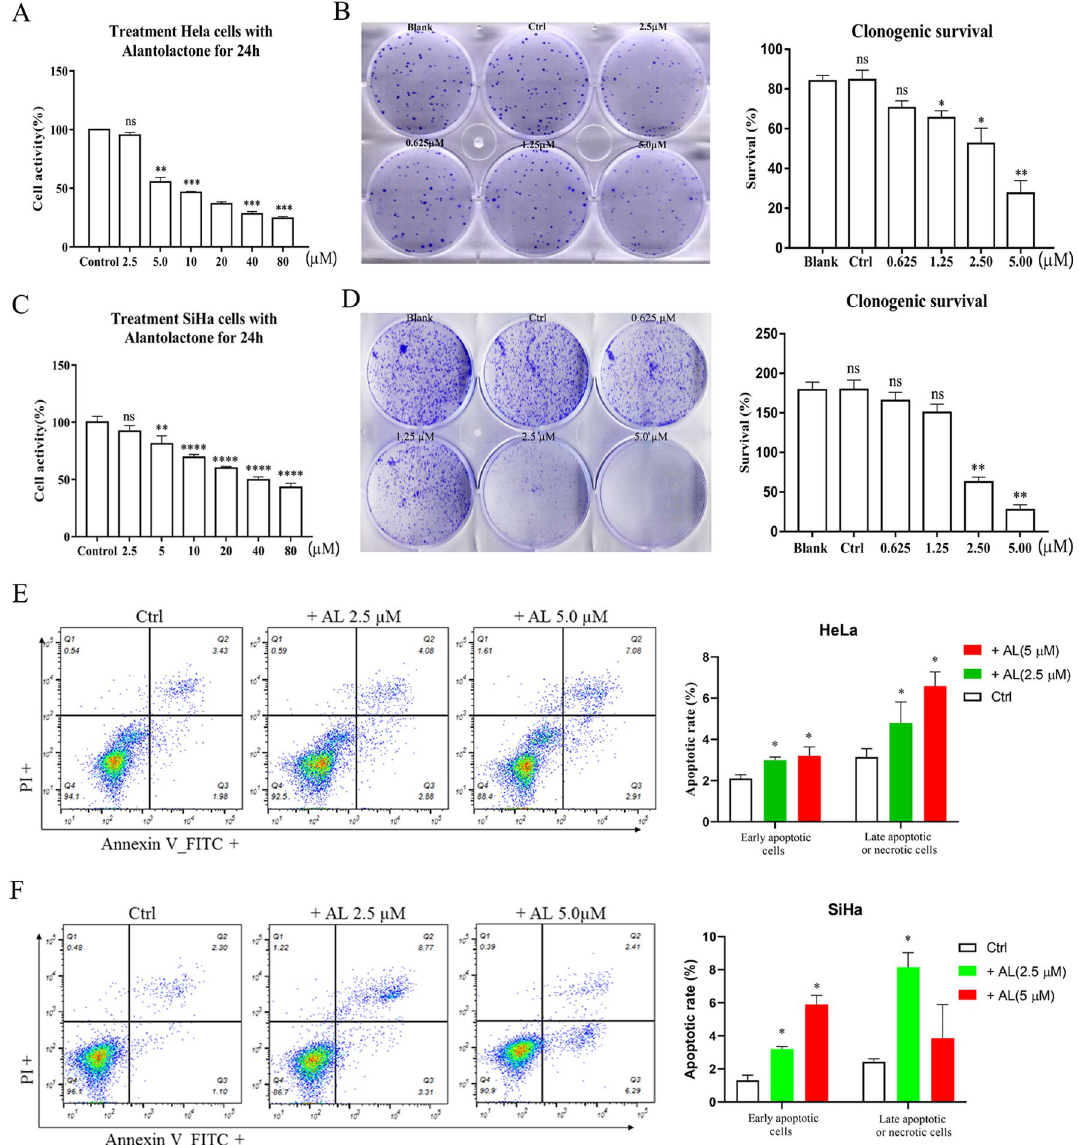
Figure 1. AL inhibits cell proliferation and promotes cell apoptosis in human cervical cancer cells. ( A – D ) AL inhibits proliferation of HeLa and SiHa cells in a dose-dependent manner. Cell proliferation was determined using CCK8 assay in HeLa ( A ) and SiHa cells ( C ), which were treated with control (vehicle), 0.625, 1.25, 2.5, 5.0, 10, 20, 40, and 80 µM AL for 24 h. Cell proliferation was determined by colony formation assay in HeLa ( B ) and SiHa cells ( D ), which were treated with blank control, control, 0.625, 1.25, 2.5, and 5.0 µM AL for 14 days. Flow cytometry using Annexin V-FITC staining shows that AL increases apoptosis of HeLa ( E ) and SiHa cells (F) in a dose-dependent manner. * P < 0.05, ** P < 0.01, *** P < 0.001, **** P < 0.0001 vs lin-1 and LC3IIB, decreased the expression of substrate P62 of Bcl-2 and LC3IIB, decreased the expression of EMT-related proteins, and inhibited P-STAT3 signaling pathway (Fig. 4A). Overexpression of BMI1 showed that indicators were reversed (Fig. 4B). To detect the induction of autophagy by decreasing BMI1 expression and its association with mitochondrial damage, BMI1 gene was knocked down, the HeLa and SiHa cells were infected with Ad-GFP-LC3B for 24 h, and then mitochondria were stained with Mito-Tracker Red CMXRos. The results showed that BMI1 gene knockdown induced autophagosome formation accompanied by a reduction in mito- chondria (Fig. 4C). After the expression of BMI1 gene was suppressed, HeLa and SiHa cells were infected with Ad-mcherry-P62 for 48 h, and fluorescence microscopy was used to detect the expression of P62. It was found that BMI1 gene knockdown induced a decrease in P62 expression, indicating that the occurrence of autophagy negatively correlated with BMI1 expression (Fig. 4D).